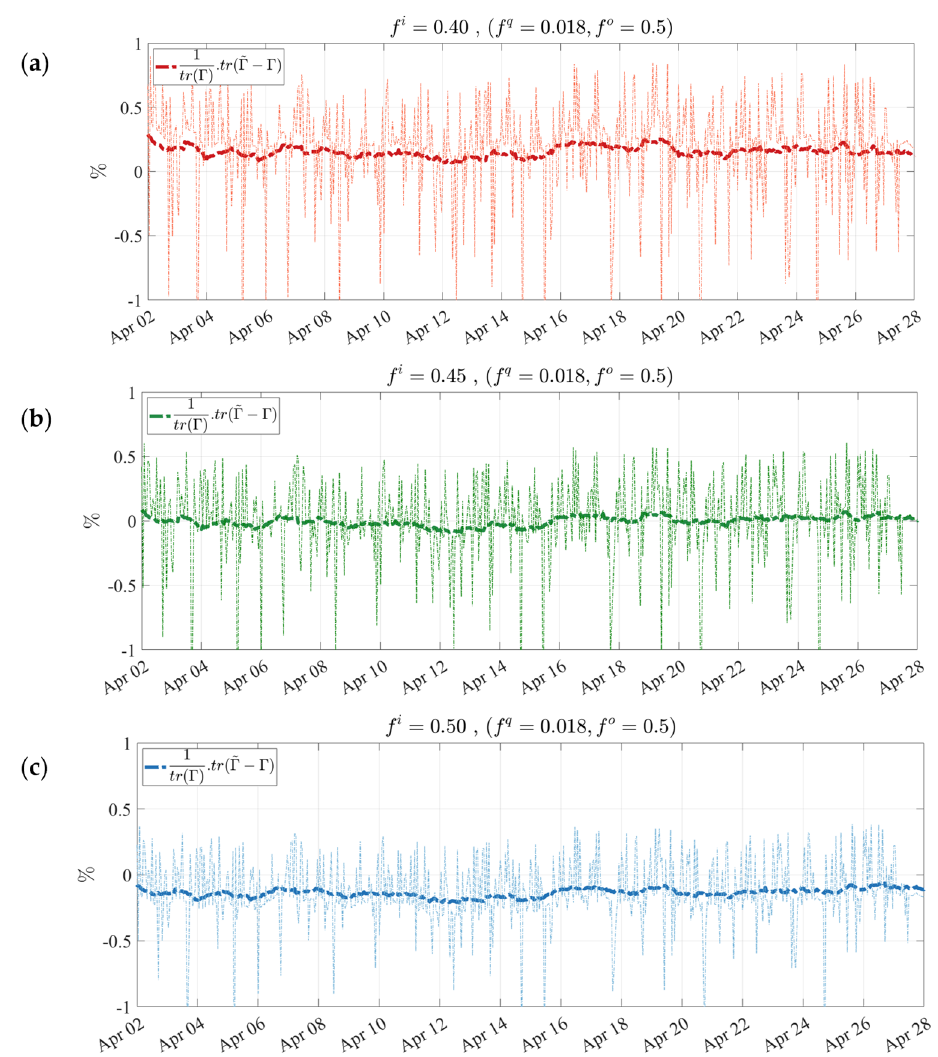
Figure 6. Normalized innovation variance consistency diagnostic for a ( a ) low ( f i = 0.40), ( b ) proper ( f i = 0.45), and ( c ) high ( f i = 0.50) initial error parameter value.